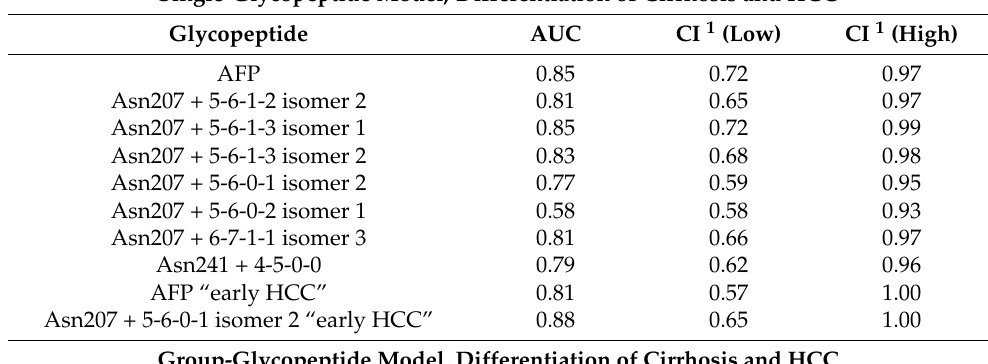
Area under the curve (AUC) comparing single-glycopeptide models, and group- glycopeptide models for the evaluation of cirrhosis and HCC samples. MVSHHN184LTTGATLINE = Asn184, NLFLN207HSE = Asn207, VVLHPN241YSQVDIGLIK = Asn241, and AFP = alpha- fetoprotein. Glycan nomenclature: HexNAc, Hex, Fuc, NeuAc ( N -acetylhexosamine, hexose, fucose, N -acetylneuraminic acid,